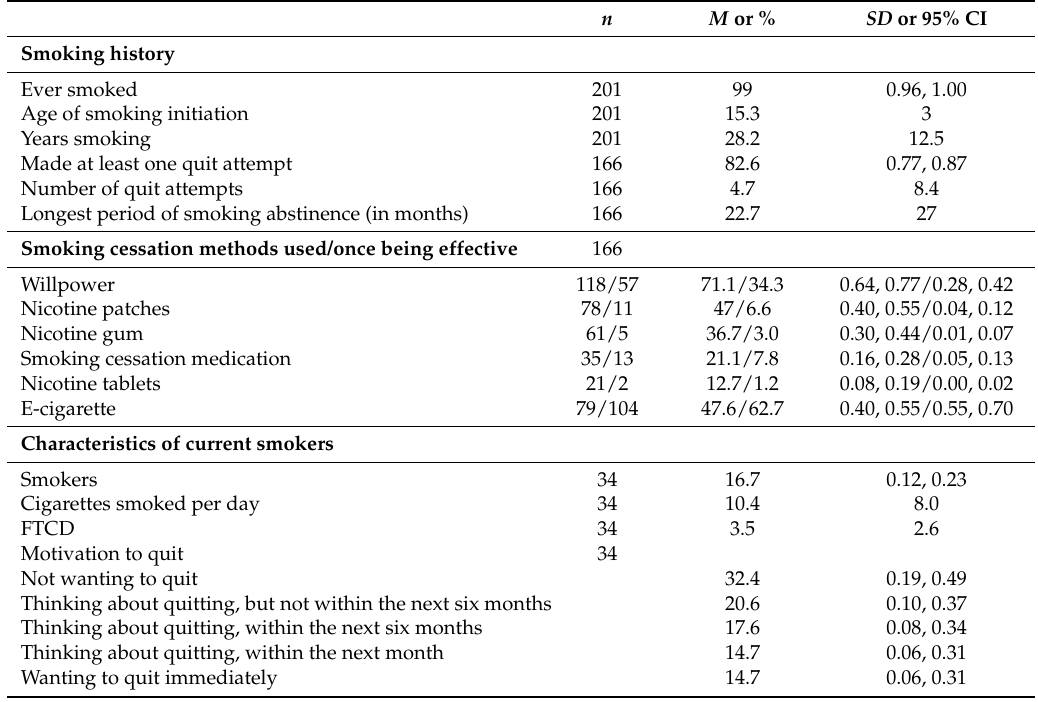
Table 2. Smoking history and current smoking status (mean ( SD ) or % (95% CI)). FTCD: Fagerström Test for Cigarette Dependence.